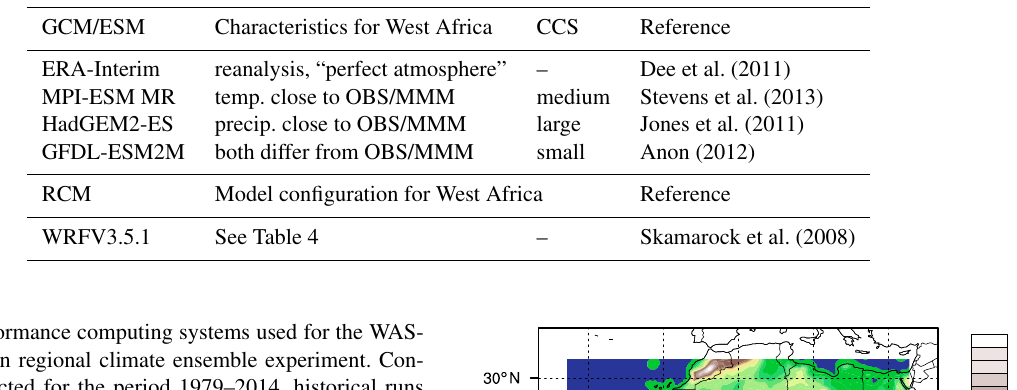
Table 2. Reanalyses and global circulation models (earth system models) used as forcing data for the long-term regional climate simulations, and regional climate model used to conduct the ensemble experiment. The characteristics of the forcing models for Africa and their climate change signal (CCS) are taken from Elguindi et al. (2014); OBS denotes observations and MMM denotes the CMIP5 multi-model ensemble mean.